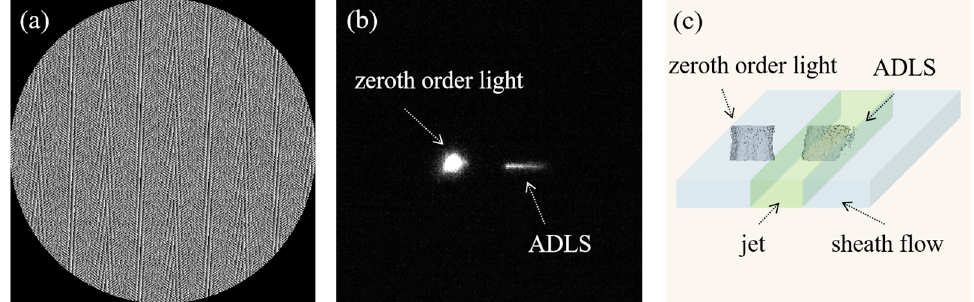
Figure 7. ( a ) The phase map of generating the ADLS. ( b ) Experimental visualization of the zeroth order light and ADLS with an inverted fl uorescence microscope, using a 50 μmol/L concentration fl uorescein sodium salt (SIGMA, 46970-100G, Roedermark, Germany) solution. ( c ) 3D construction of the ADLS from fl uorescent images using MATLAB software (MATLAB R2022a, Mathworks , Natick, Massachuse tt s, USA). The ADLS is 12 μm wide, 12 μm high, and 0.8 μm thick.